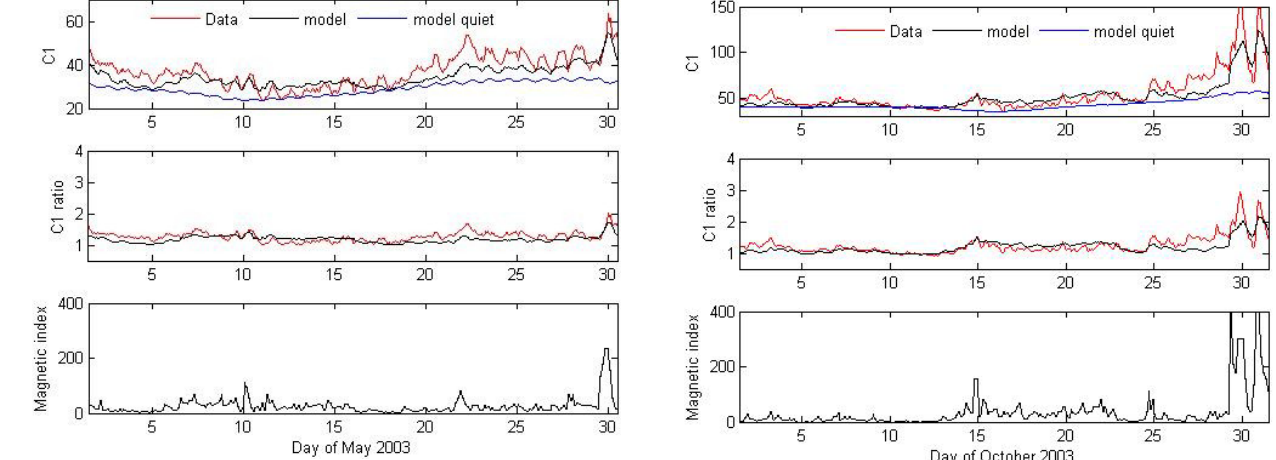
Fig. 8. Variations with UT of the c 1 projection coefficients for the SN orbit segments during October 2003. Upper panel: variations of the CHAMP density c 1 projection co- efficient (red line) and those computed with the actual (black line) and quiet (blue line) NRLMSISE-00 models using Mg II instead of F10.7 as a proxy for the solar activity. Middle panel: variations of the c 1 (CHAMP)/ c 1 (NRLMSISE-00 quiet) (red line) and c 1 (NRLMSISE-00 actual)/c 1 (NRLMSISE-00 quiet) (black line) ratios. Lower panel: variations of the a p magnetic activity